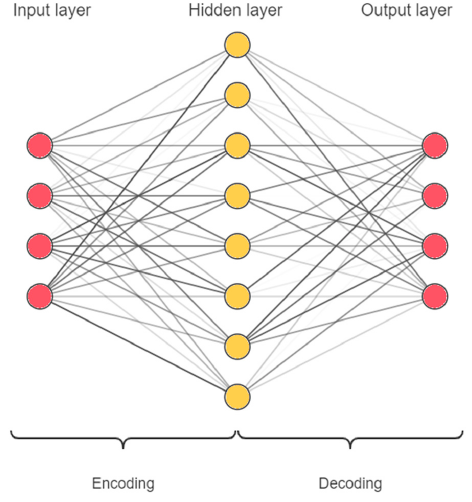
Figure 1. The structure of an autoencoder (AE), including input layer, hidden layer and output layer.